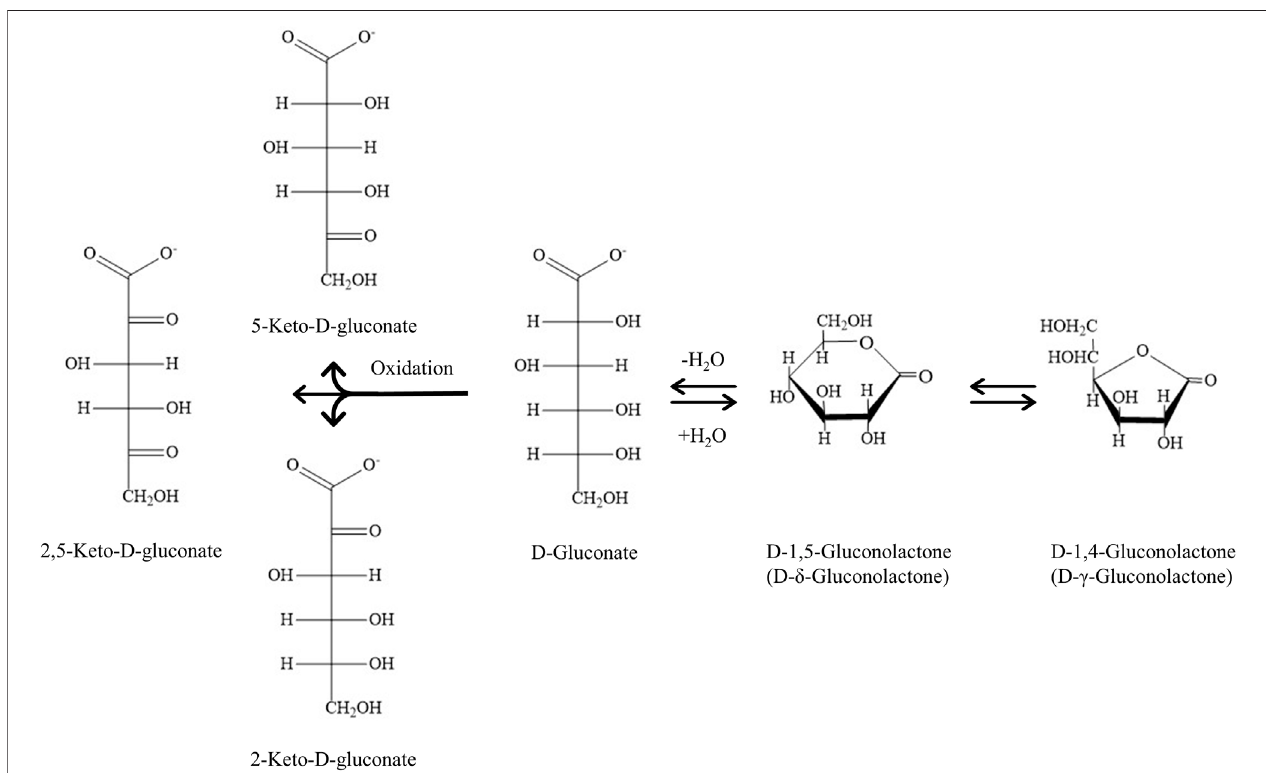
FIGURE 1 | Gluconic acid (GA) and its derivatives. Chemical equilibrium of GA and its lactones and GA transformation to keto-gluconates by a strong oxidant in aqueous solution.